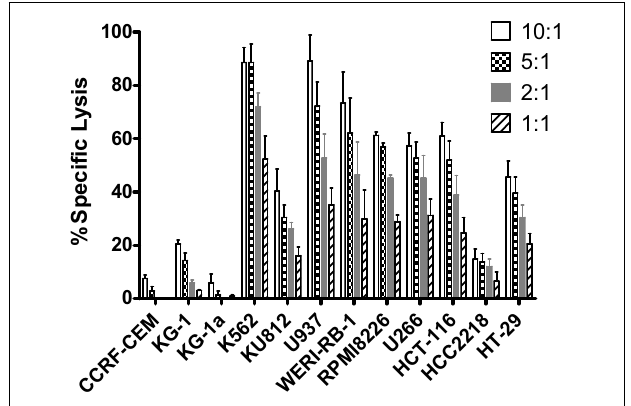
FIGURE 5 | Cytotoxicity of ex vivo -expanded Day 21 pNK cells against a wide range of tumor cell lines . Cytotoxicity of ex vivo -expanded pNK cells ( n = 6) against a wide range of tumor cell lines at E:T ratio of 10:1, 5:1, 2:1, and 1:1 as